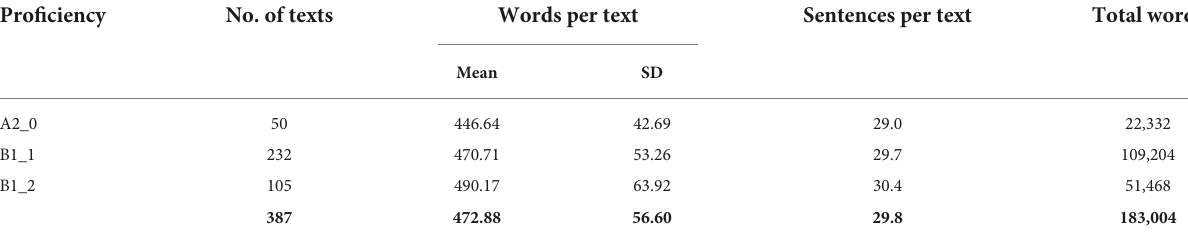
TABLE 1 Descriptive statistics of the corpus used in the